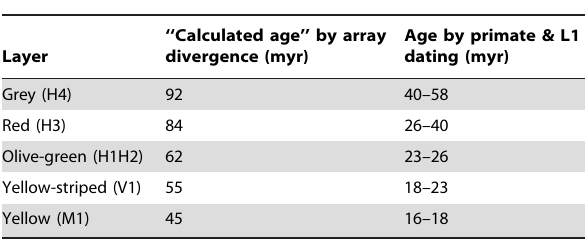
Table 4. Age of AS layers calculated by different